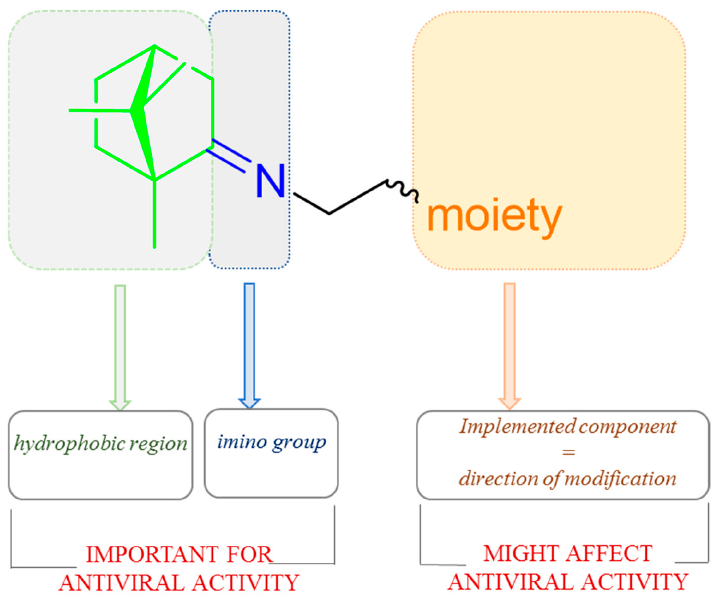
Figure 22. The design strategy for (+)-camphor-based imines with effectiveness biological activity.